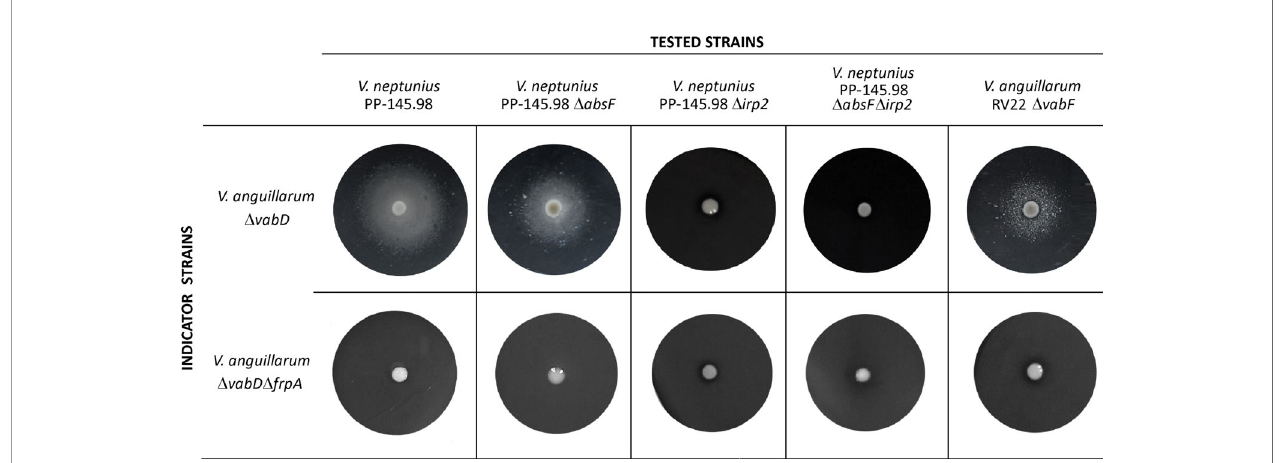
FIGURE 4 | Cross feeding assay to test the production of piscibactin by V. neptunius 145.98 wild type strain and its derivative D absF and D irp2 single mutants and D irp2 D absF double mutant. Indicator strains were inoculated within the CM9 plates containing 100 µM of 2,2 ’ -dipyridyl. Tested strains were placed as a loop full of bacterial biomass on the agar surface. The presence of a growth halo shows that the indicator strains can use the siderophores produced by the tested strains to overcome the iron limitation.